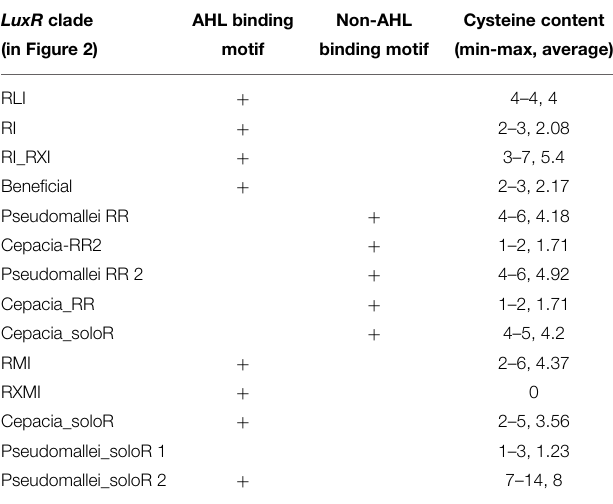
TABLE 2 | Potential disulfide bridges predicted for various clades of Burkholderia LuxR proteins. Clade